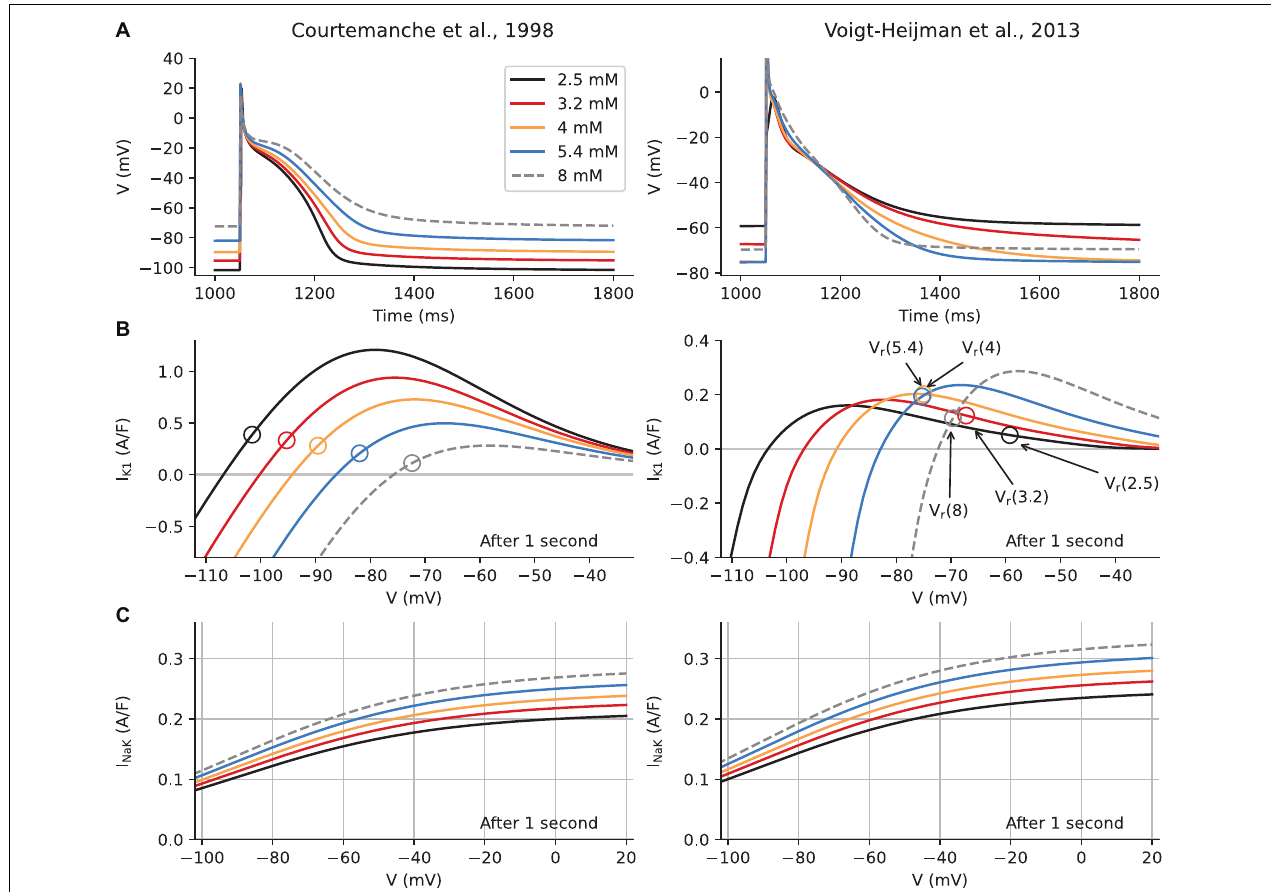
FIGURE 2 | Immediate effects of alterations in [K + ] o levels on human atrial Action Potential (AP), Resting Potential (V r ), and underlying ionic currents. Computational results for the Courtemanche et al. model are shown in the left column, and analogous results from the Voigt-Heijman et al. model are shown on the right. Each panel in Row A shows five superimposed AP waveforms that illustrate how [K + ] o -induced changes in repolarization affect the AP waveform and the resting potential, V r , 1 s after a step change in [K + ] o . Note that in both models, hyperkalemia depolarizes V r , but hypo kalemic effects are model-dependent. In the Courtemanche et al. model the waveforms for the [K + ] o levels representing clinical hypokalemia (3.2 and 2.5 mM) show a pronounced hyperpolarization and a shortening of the AP, while in the Voigt-Heijman et al. model hypokalemia depolarizes V r and prolongs the AP. The origins of this difference can be seen in Row B , which depicts the I-V curve for I K1 at the selected [K + ] o levels. Note that these are color-coded to match the AP traces in Row A, while open circles denote the resting potential of the myocyte in the corresponding [K + ] o condition. In the Courtemanche et al. model, the only effect of lowering [K + ] o is an increase in electrochemical driving force for I K1 (which is more larger at more depolarized potentials, causing the appearance of a peak current that moves “left and up”). In the Voigt-Heijman et al. this effect is still present, but the [K + ] o -sensitivity of I K1 rectification and conductance counteracts this effect. Importantly, as described in section “Results” and Supplementary Section 3 , the [K + ] o dependence of I K1 gives rise to a complex pattern of changes in the non-linear inwardly rectifying I–V relation for I K1 . The superimposed I–V curves in each panel of Row C illustrate the corresponding I–V curve of electrogenic current, I NaK , generated by the Na + /K + pump, in each of the [K + ] o levels that were used for this